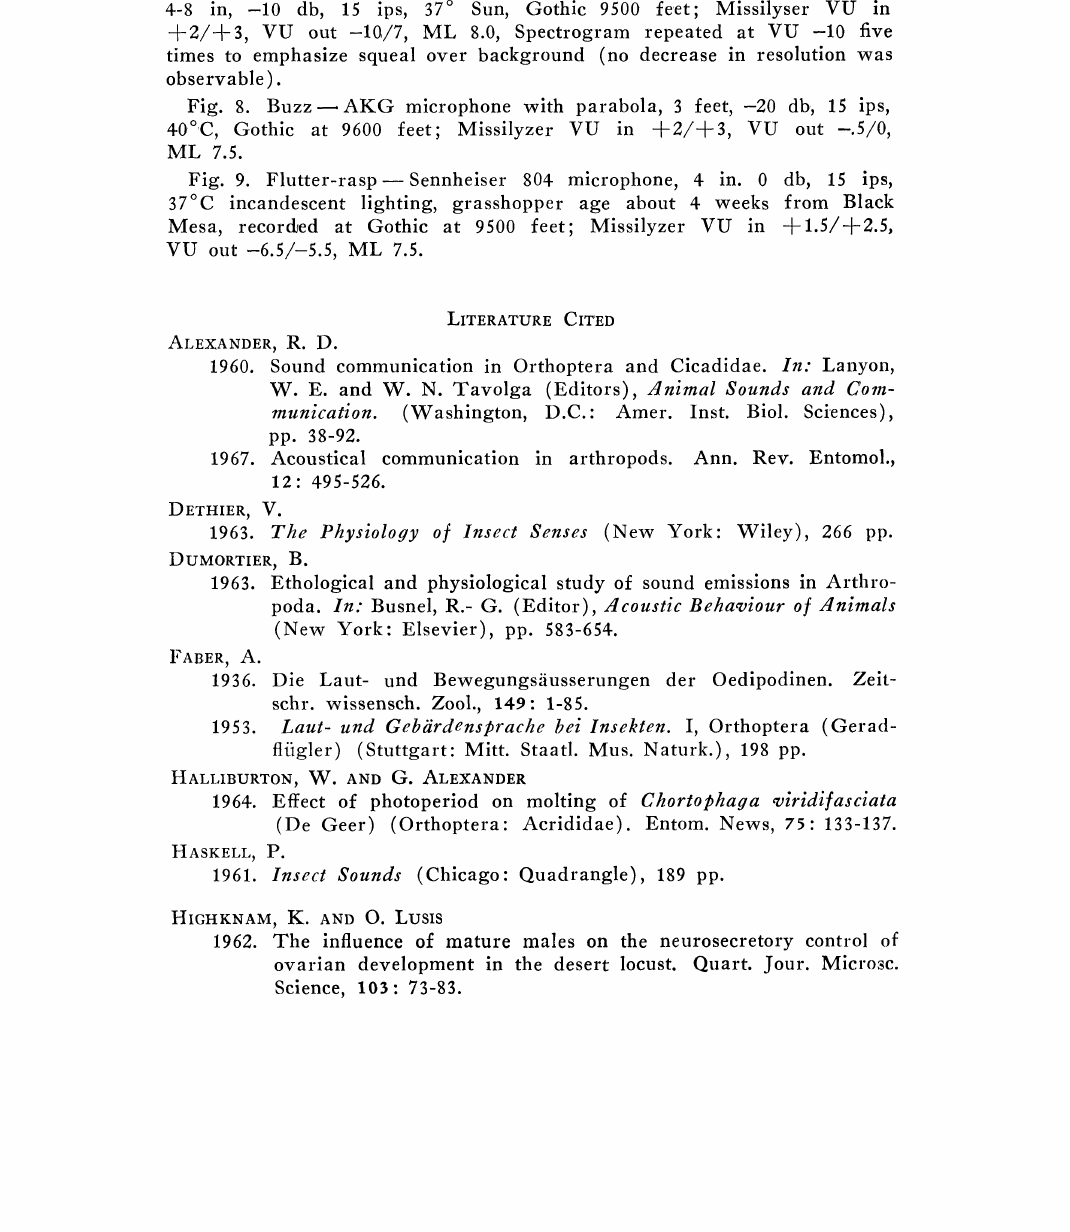
Fig. 4. Chirp--Sennheiser 804 microphone, 3-4 in., 0 db, 15 ips, 37 incandescent lighting, grasshopper age 4 weeks from Black Mesa, recorded at Gothic .at 9500 feet; Missilyzer VU in-1/0, VU out -6.5/-.5, ML 7.5. Fig. 5. Alarm cry of a chipmunk (Eutamias sp.)--AKG microphone with parabola, 20 feet,-20 db, 15 ips, about 25C (6:00 MDT), recorded at Gothic, 9700 feet; Missilyzer VU in -[-2/3, VU out-10/-7, ML 8.0. Fig. 6. Crepitation and squeal mAKG microphone without parabola, 4-8 in,-10 db, 15 ips, 37 Sun, Gothic 9500 feet; Missilyser VU in +2/+3, VU out-10./7, ML 8.0, Spectrogram repeated at VU-10 five times to emphasize squeal over background (no decrease in resolution was observable). Fig. 8. Buzz-AKG microphone with parabola, feet,-20 db, 15 ips, 40’C, Gothic at 9600 feet; Missilyzer VU in -[-2/-[-3, VU out-.5/0, ML 7.5. Fig. 9. Flutter-rasp--Sennheiser 804 microphone, 4 in. 0 db, 15 ips, 37C incandescent lighting, grasshopper age about 4 weeks from Black Mesa, recor&ed at Gothic at 9500 feet; Missilyzer VU in -+-1.5/+2.5, VU out-6.5/-5.5, ML 7.5. LITERATURE CITED ALEXANDER, R.